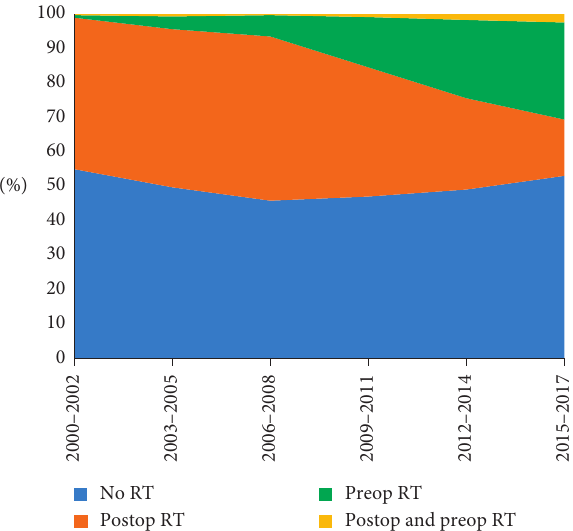
Figure 2: The use of perioperative radiotherapy for grades II and III resected soft tissue sarcoma in the Netherlands between 2000 and 2017. Abbreviations: RT � radiotherapy, postop � postoperative, and preop �